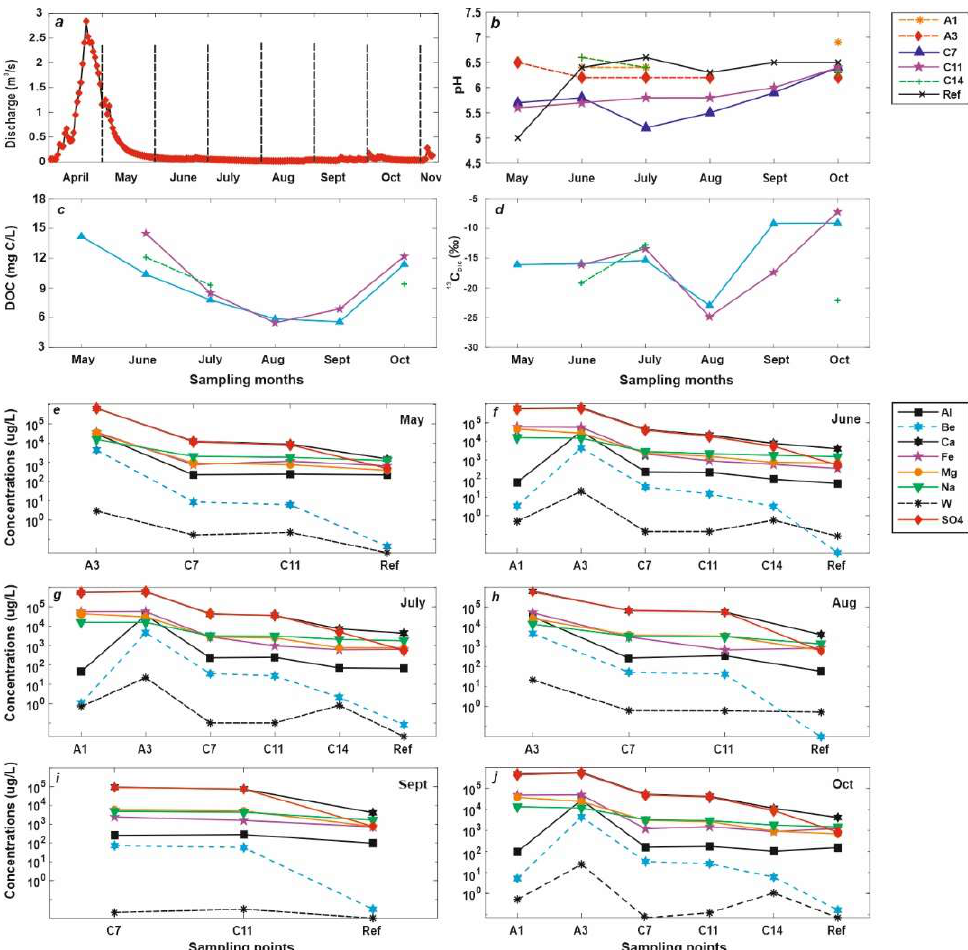
Figure 3. ( a ) Time series data of surface water discharge in the study area from April to November 2018. ( b – d ) Temporal variations in pH, DOC and δ 13 C DIC for A1, A3, C7, C11, C14 and the reference point (Ref) from May to October; ( e – j ) temporal and spatial variations in dissolved ion concentrations for A1, A3, C7, C11, C14 and Ref.